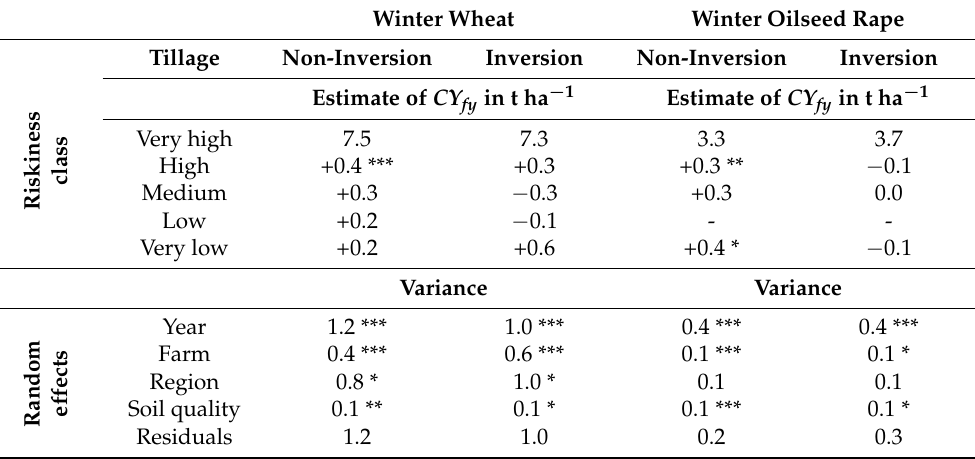
Table 3. Regression: Effect of crop sequence riskiness and tillage on ‘crop yield’ ( CY fy ) (t ha − 1 ) in winter wheat and winter oilseed rape. Significance levels: * p < 0.05, ** p < 0.01 and *** p < 0.001.